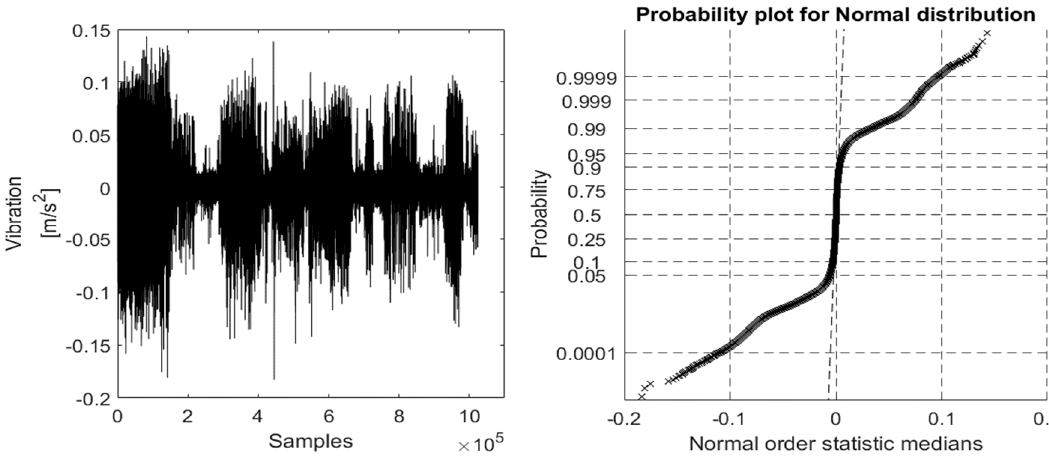
Figure 17. Raw vibration data signal from accelerometer #2 and its ProbPlot in outer-race fault (ORF) case under variable speed environment.